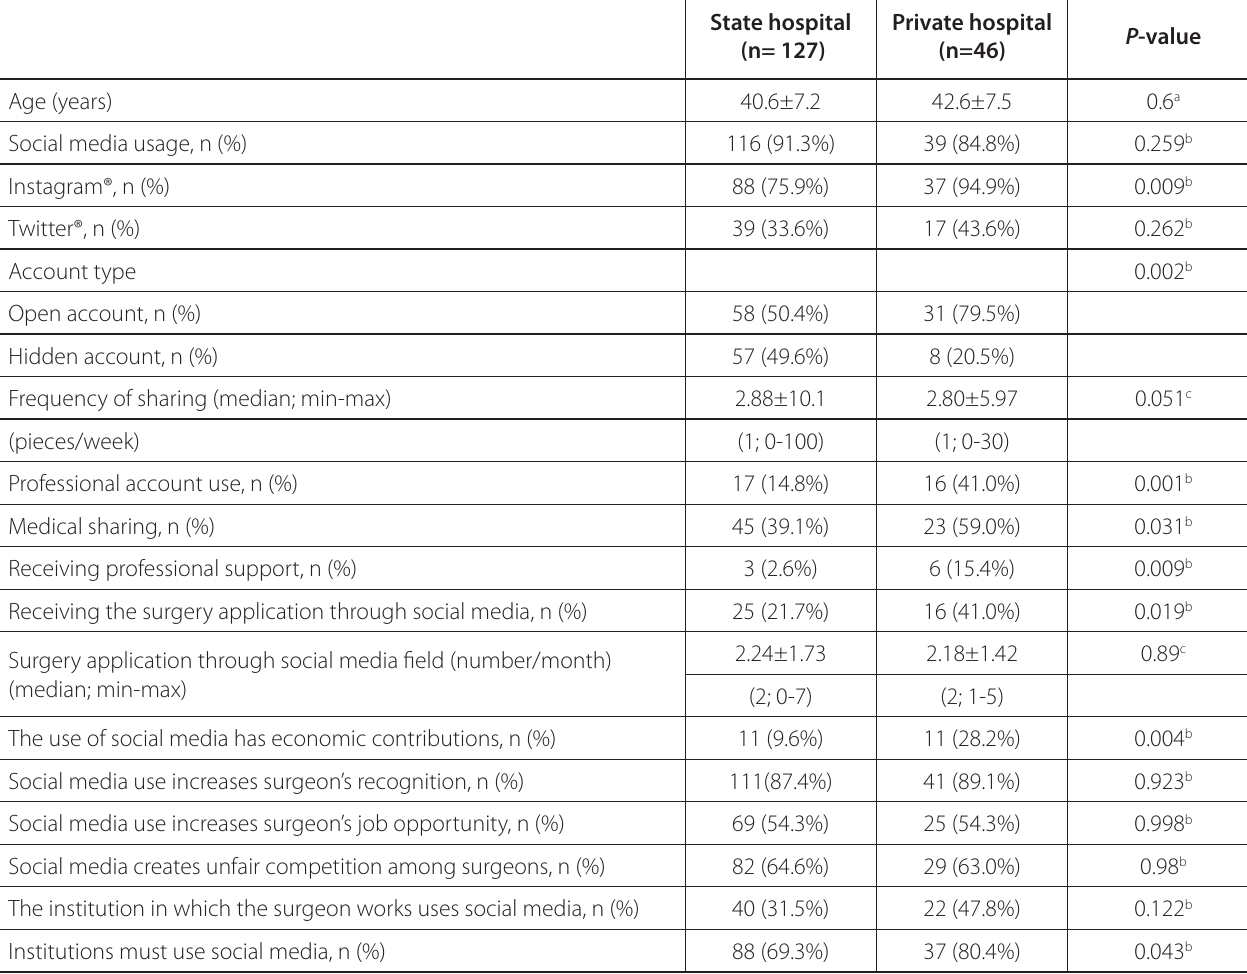
Table 2 . Results among cardiovascular surgeons according to the